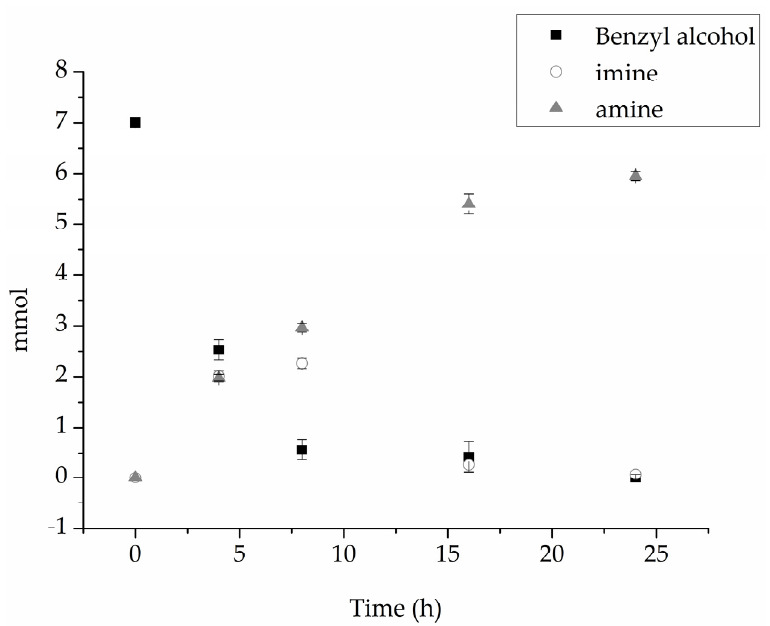
Figure 4. Product distribution for Au SI /NiO. Reaction conditions: isopropylamine (7 mmol), benzyl alcohol (7 mmol), total volume in xylene (30 mL), BA/Au: 250 mol %, 150 °C, 5 atm, N 2 , 1200 rpm.